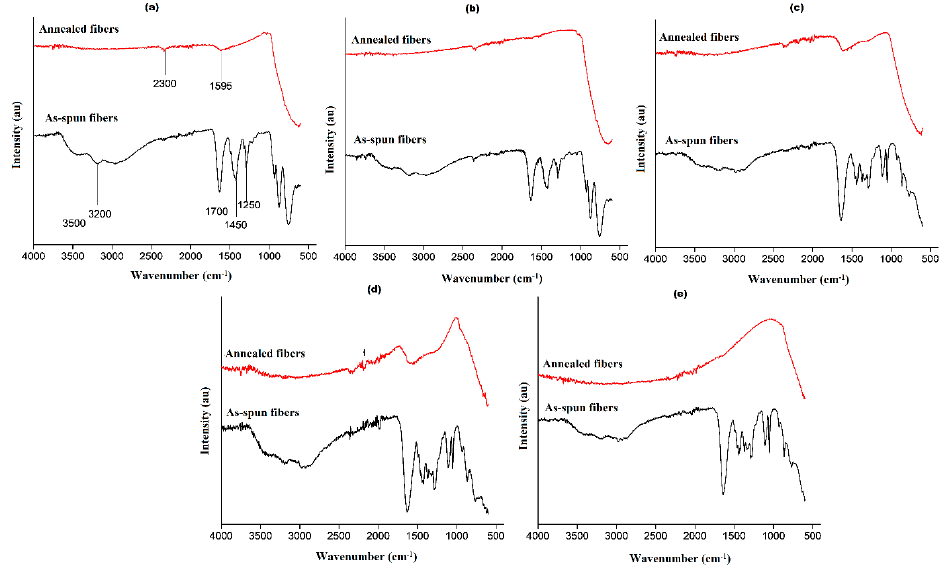
Figure 6. FTIR spectra of fibers before and after annealing: ( a ) 0% TiBALDH, ( b ) 10% TiBALDH, ( c ) 50% TiBALDH, ( d ) 90% TiBALDH, and ( e ) 100% TiBALDH.